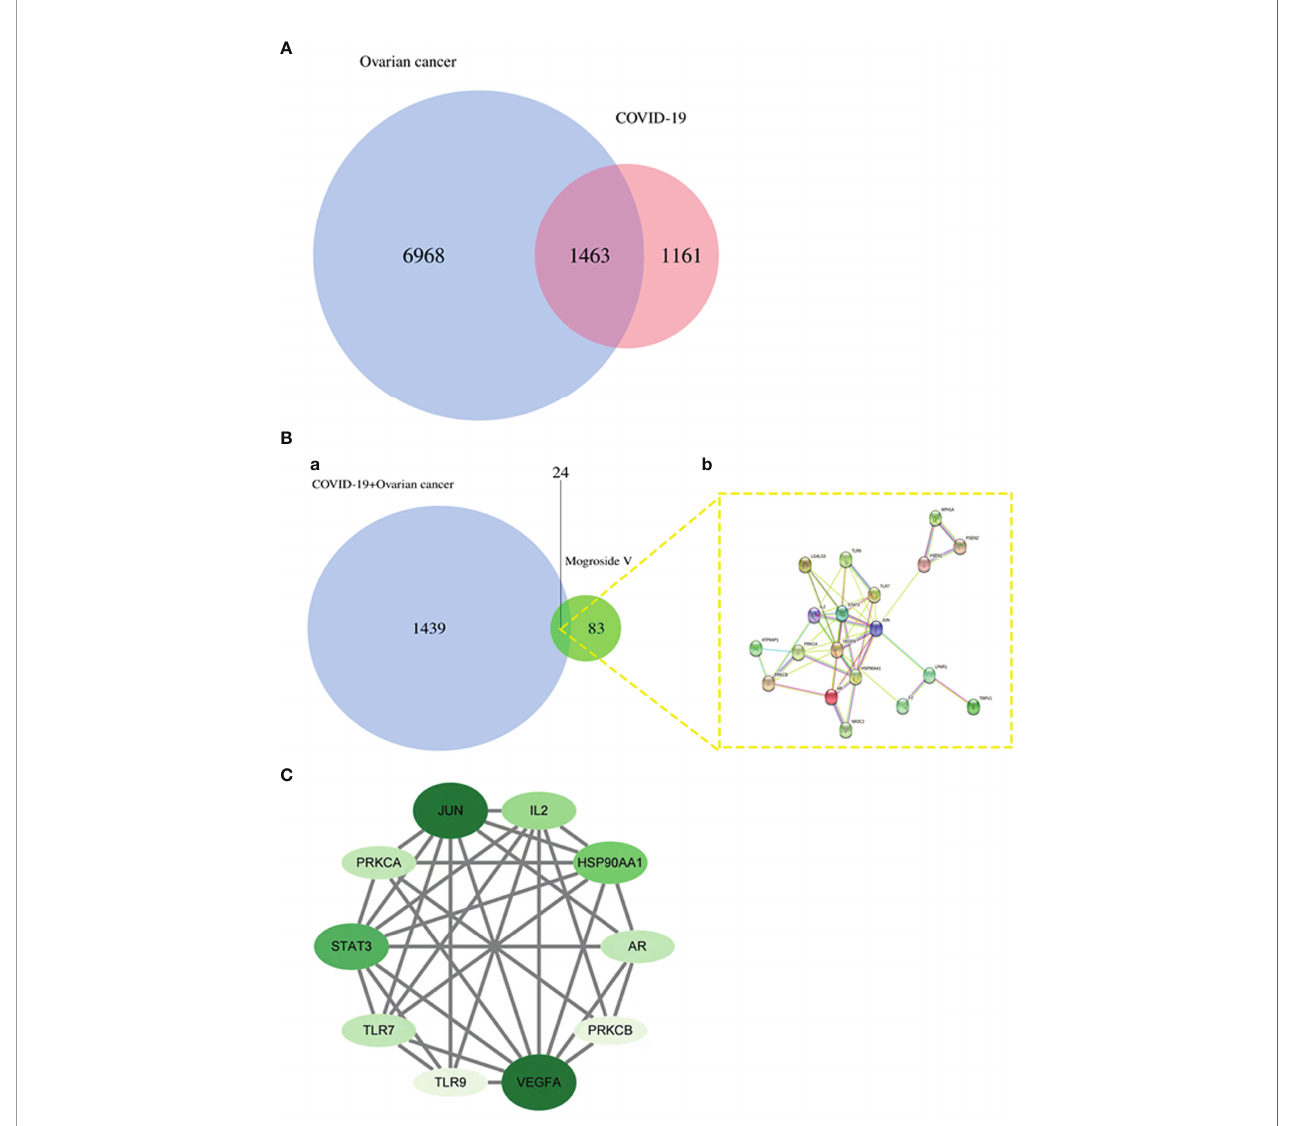
FIGURE 1 | Bioinformatics and network pharmacology analyses. (A) Ascertainment of 1,463 COVID-19 and ovarian cancer-related genes. (B) The Venn diagram identi fi es 24 common genes (a) in mogroside V and COVID-19/ovarian cancer, followed by an associated diagram within these common genes (b) . (C) Screening of 10 core targets in mogroside V against COVID-19/ovarian